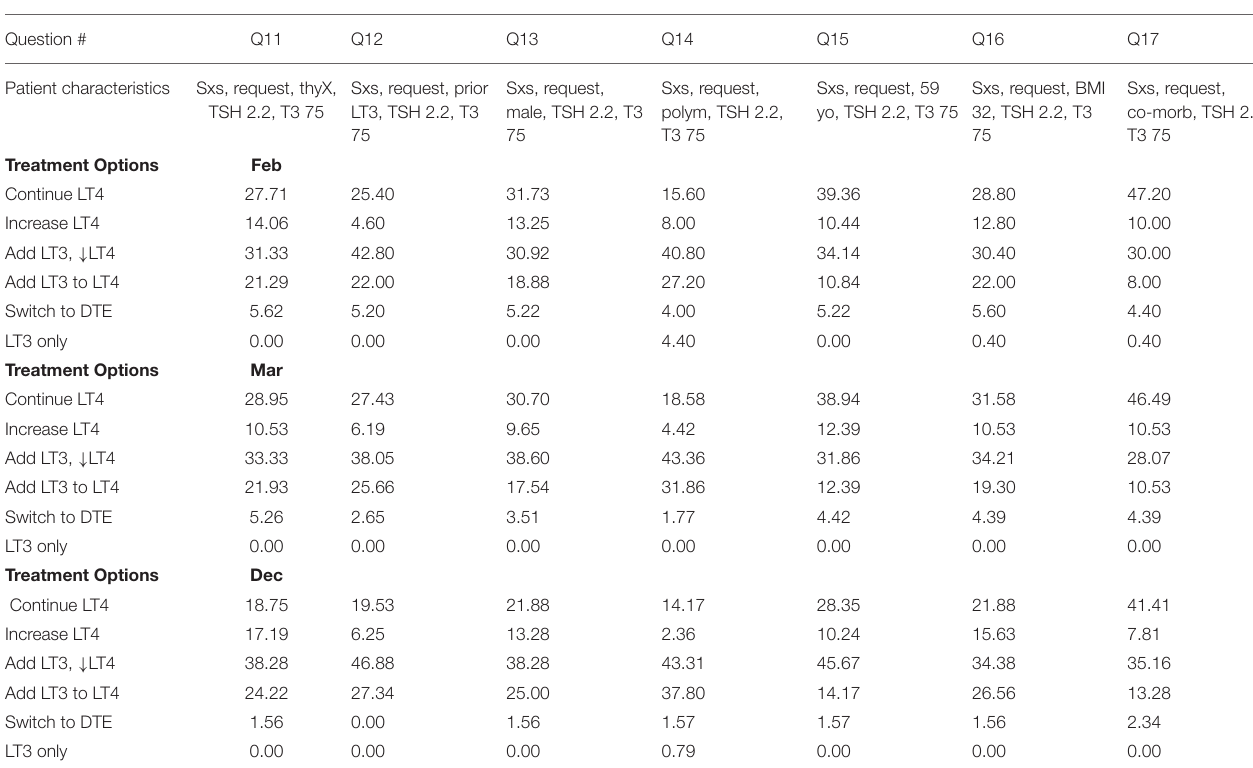
TABLE 2B | Response to questions regarding therapy